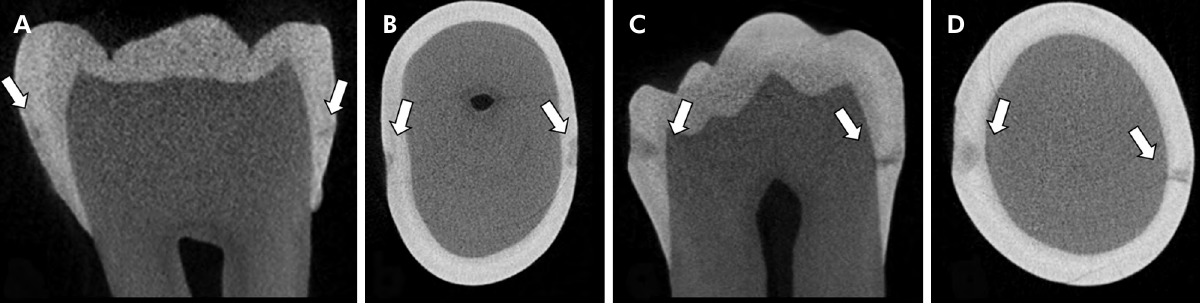
Figure 1. Micro-computed tomography images showing proximal carious lesions (white arrows) confined to the outer surface of enamel (A and B) and reaching the dentin-enamel junction (C and D).